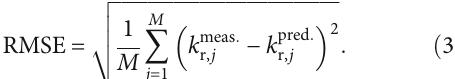
Figure 2: Pore sizes simulated by the Monte Carlo